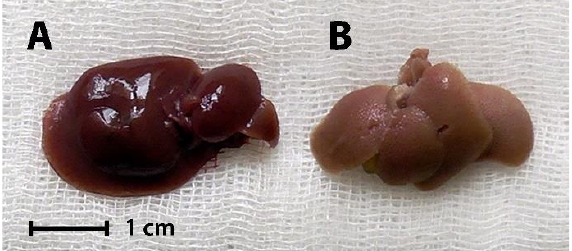
Figure 2. Macroscopic features of experimental liver disease induced in Control mice. ( A ) Intact: normal liver. ( B ) Control: discolored, light tan, stiff liver with a diffuse nodular surface.